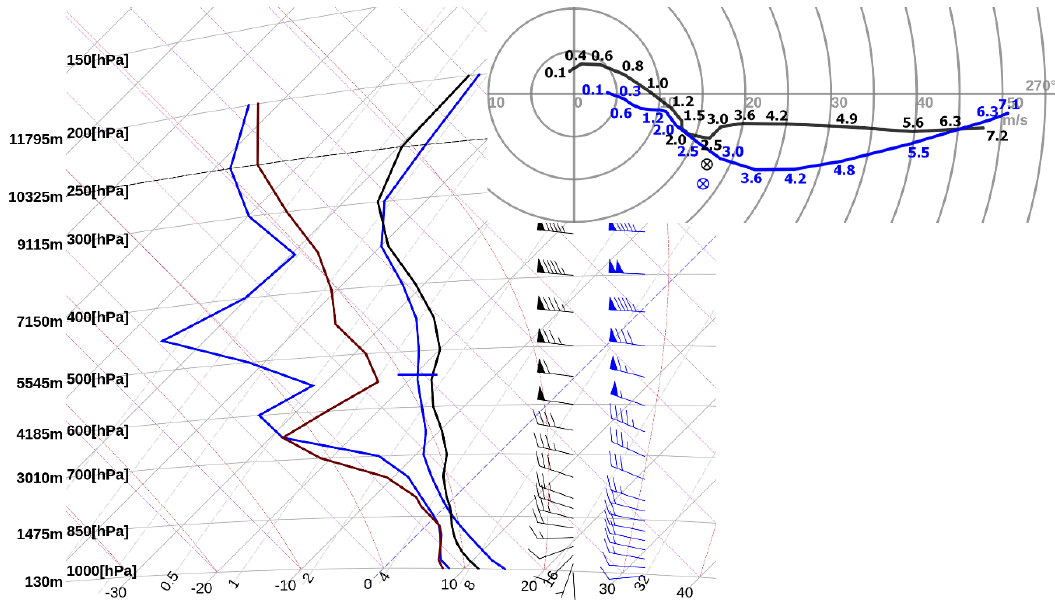
Figure 4. NWP OPM forecast tephigrams, vertical wind profiles, and hodographs on 3 October 2018 06:00 UTC with plotted storm motion vectors (crossed circles) and numbers corresponding to heights in km valid for southeastern Slovakia; NWP OPM at 10:00 UTC (black), and 12:00 UTC (blue). Equilibrium level calculated for 12:00 UTC denoted by horizontal blue line; location of forecast tephigrams denoted in Figure 5.